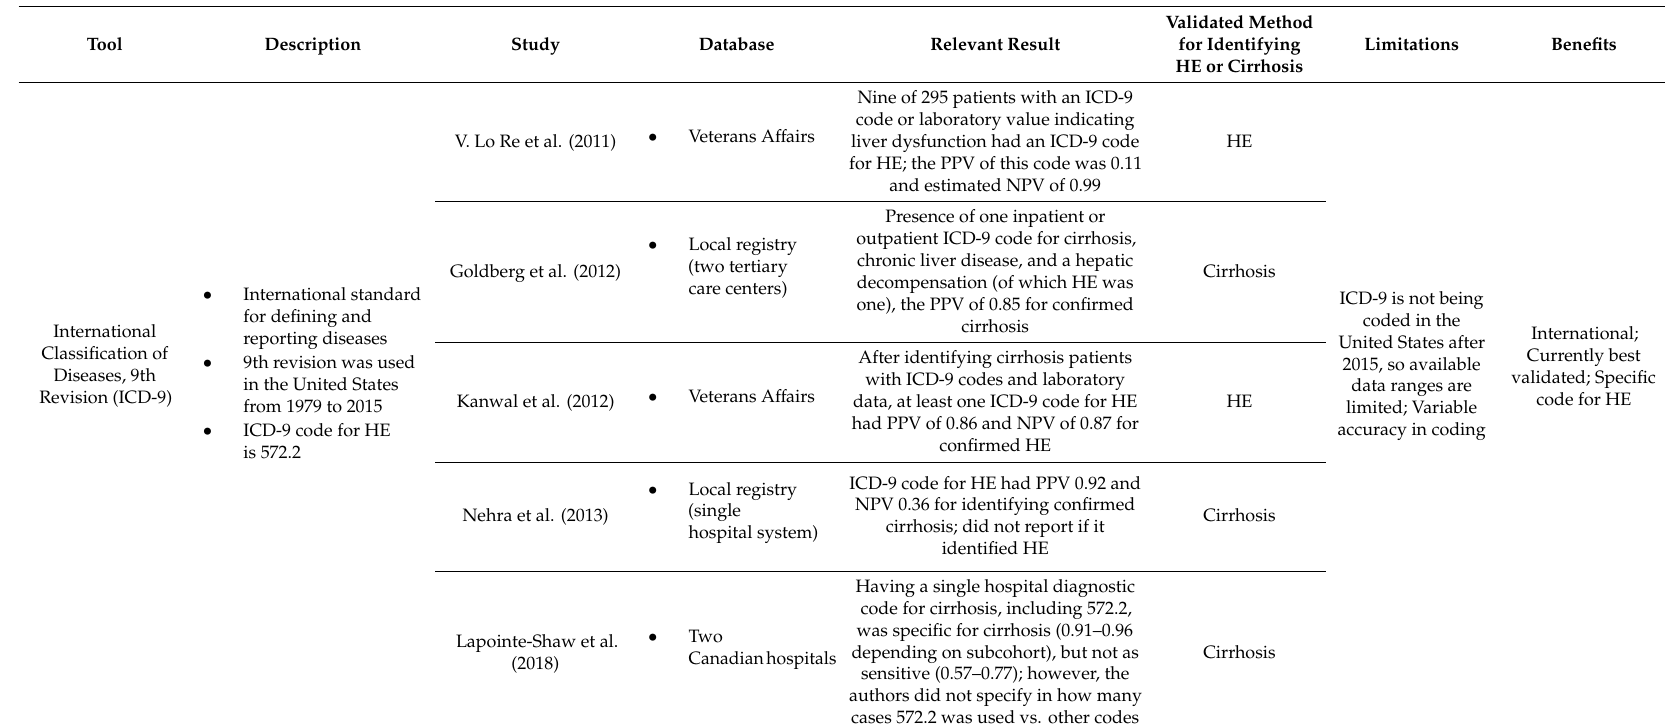
Table 1. Methods to Identify Hepatic Encephalopathy Using Administrative